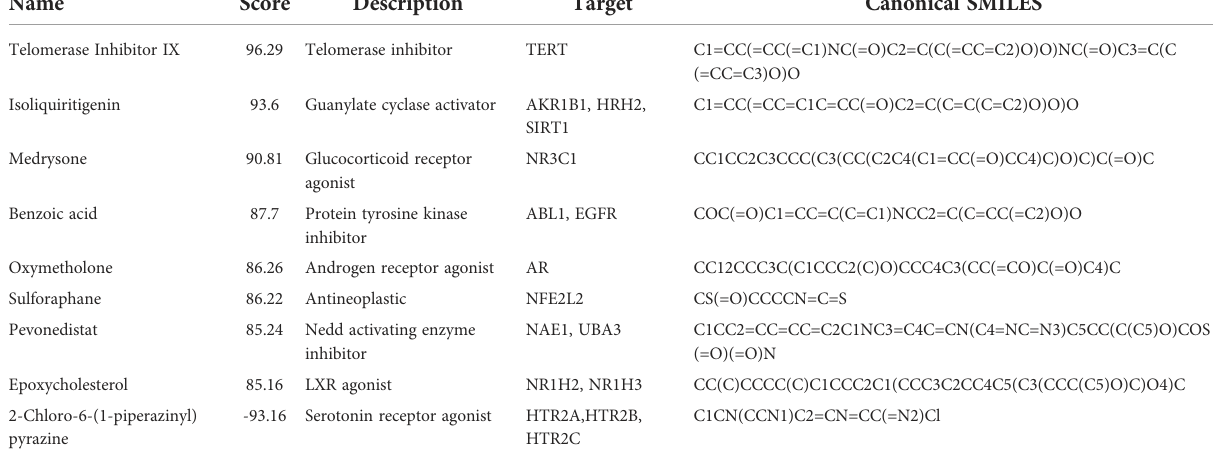
TABLE 2 Signi fi cant small molecule chemicals.